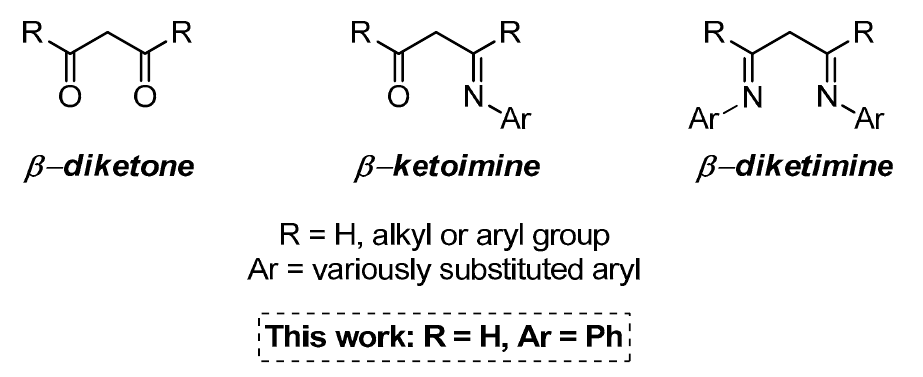
Figure 1. β‐ diketone, β‐ ketoimine and β‐ diketimine ligands. Figure 1. β -diketone, β -ketoimine and β -diketimine